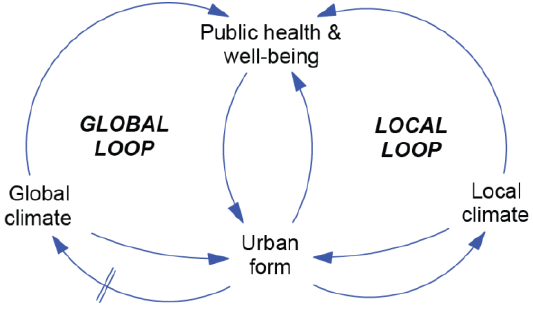
Figure 2. Global – Local Model. Figure 2. Global–Local